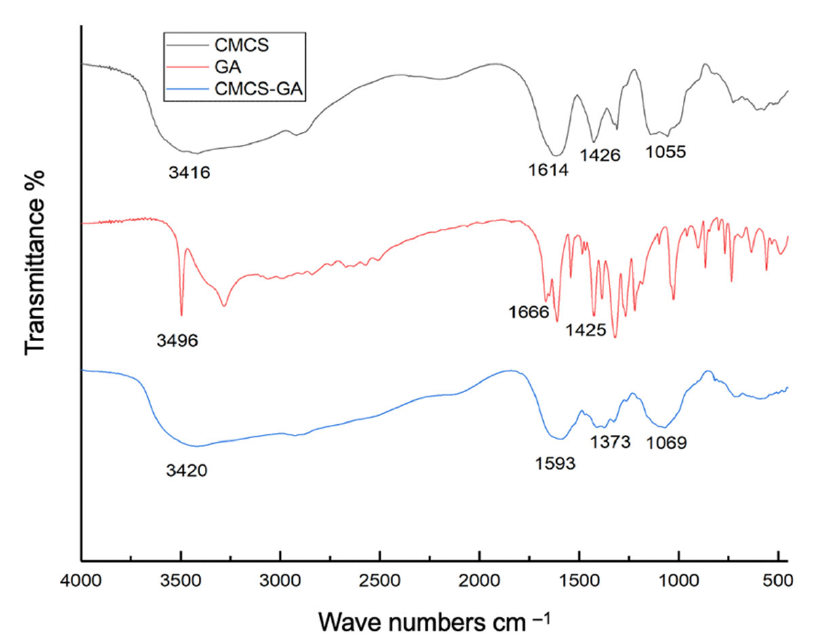
Figure 1. FTIR spectra of CMCS, GA, and CMCS ‐ GA.